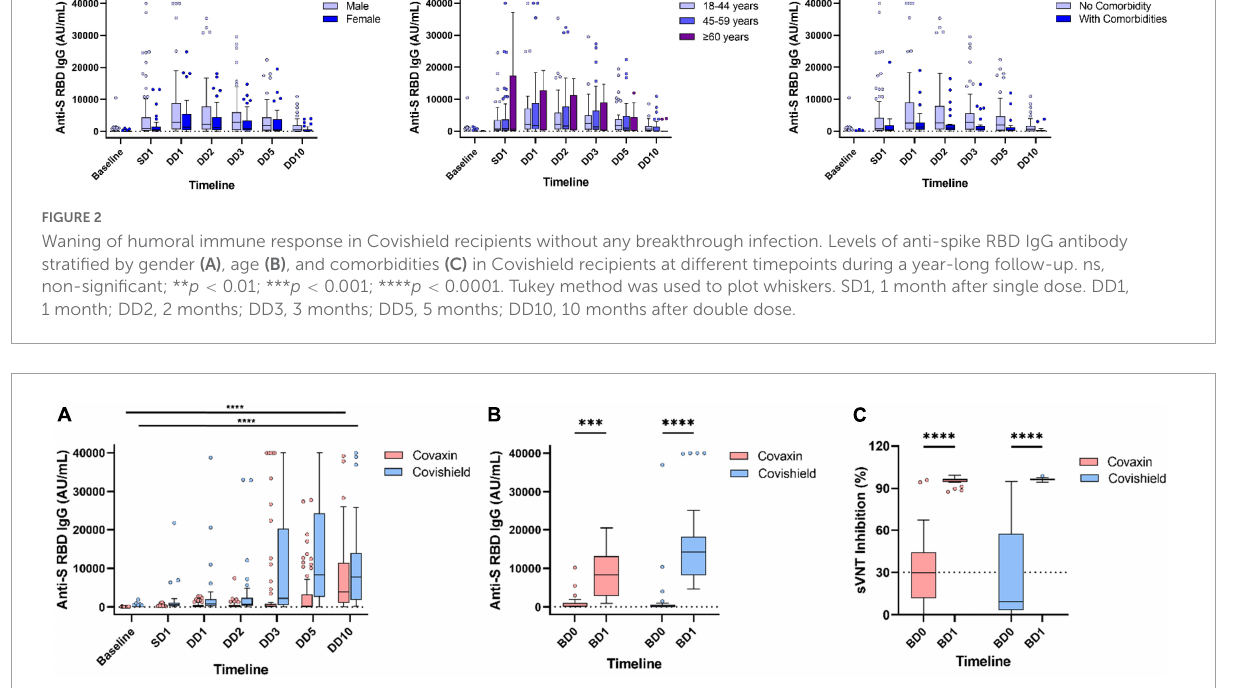
FIGURE3 Longitudinal dynamics of anti-spike RBD IgG titer in coronavirus disease-19 (COVID-19) breakthrough infection. Antibody levels at different timepoints in participants who had COVID-19 after receiving double dose of Covaxin and Covishield (A) . Anti-spike RBD IgG (B) and neutralizing antibody (C) response in breakthrough cases after administration of booster. ∗∗∗ p < 0.001; ∗∗∗∗ p < 0.0001. Tukey method was used to plot whiskers. SD1, 1 month after single dose; DD1, 1 month; DD2, 2 months; DD3, 3 months; DD5, 5 months; DD10, 10 months after double dose; BD0, before booster dose; BD1, 1 month after booster dose.